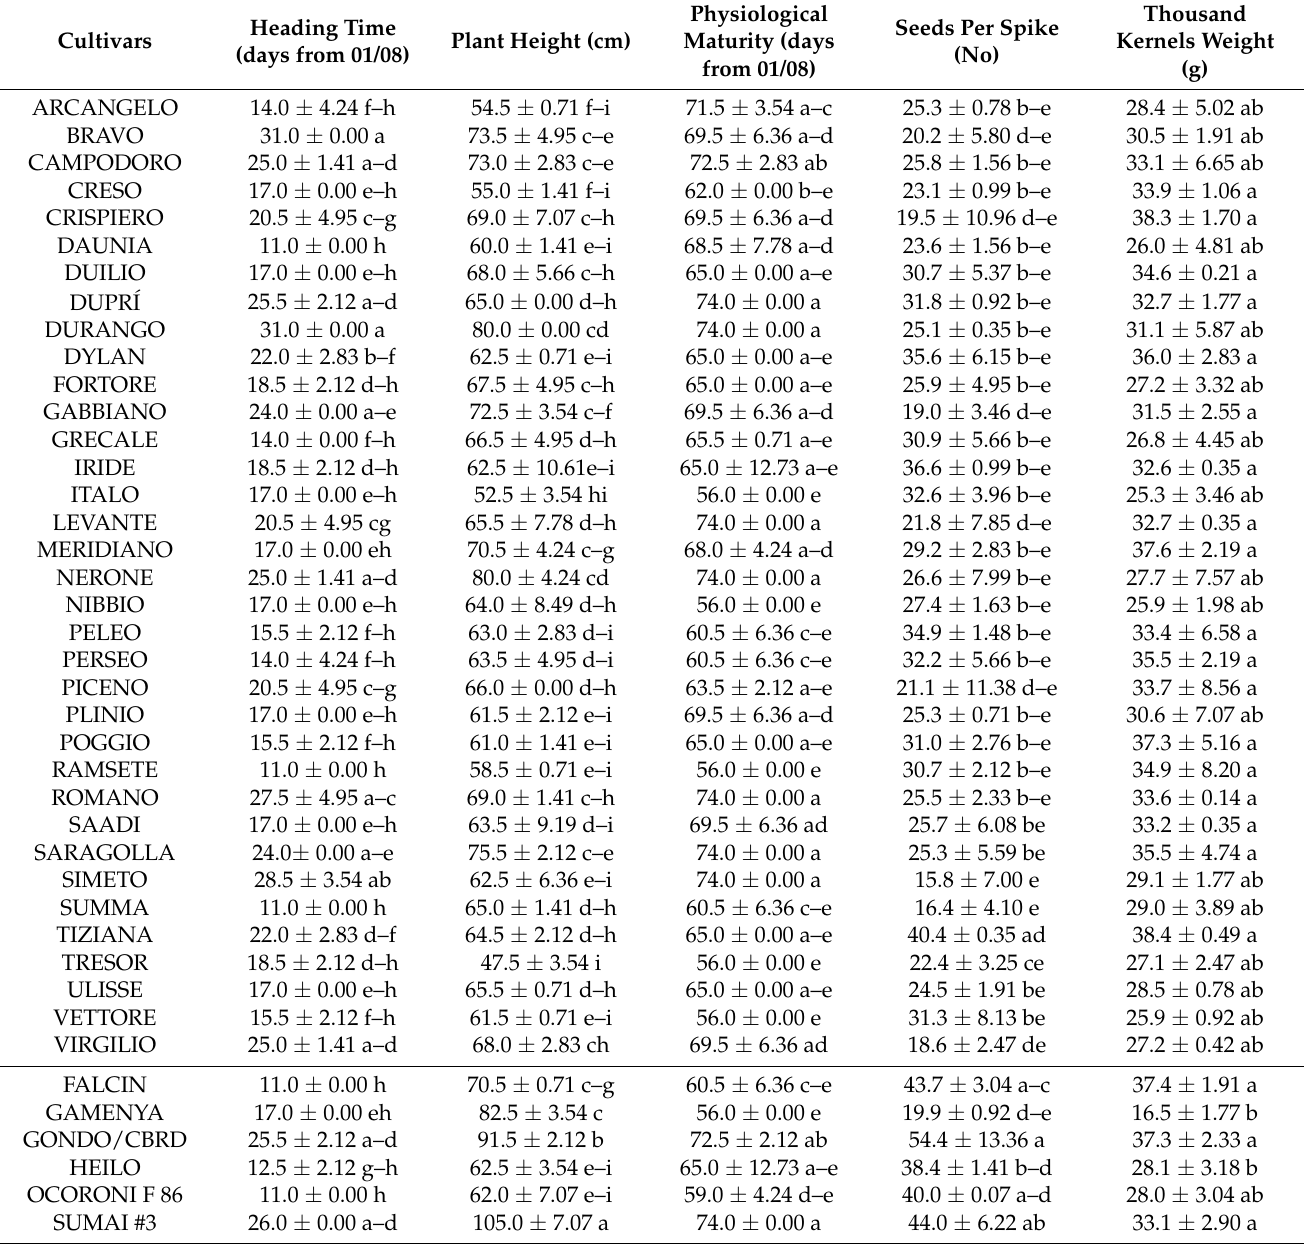
Table 2. Phenological and grain traits of 35 Italian durum wheat cultivars and 6 bread wheat cultivars used as references, tested at International Maize and Wheat Improvement Center (CIMMYT), Mexico, for susceptibility to Fusarium head blight (FHB) 1